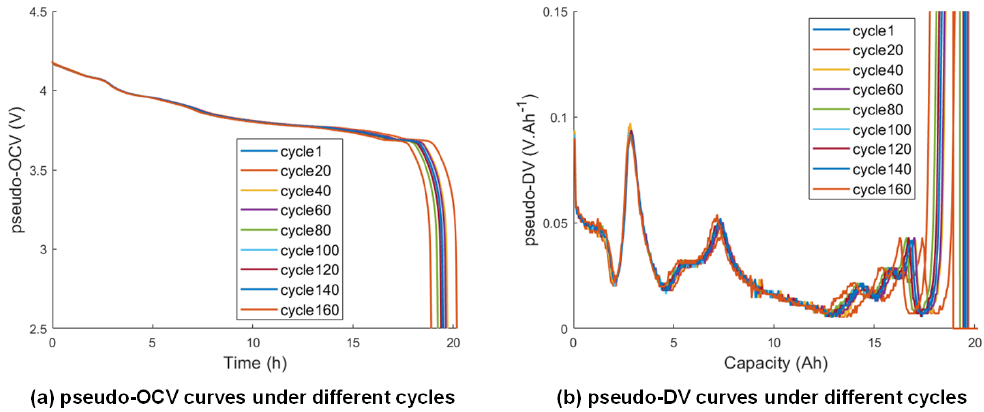
Figure 19. Pseudo-OCV/DV curves under different